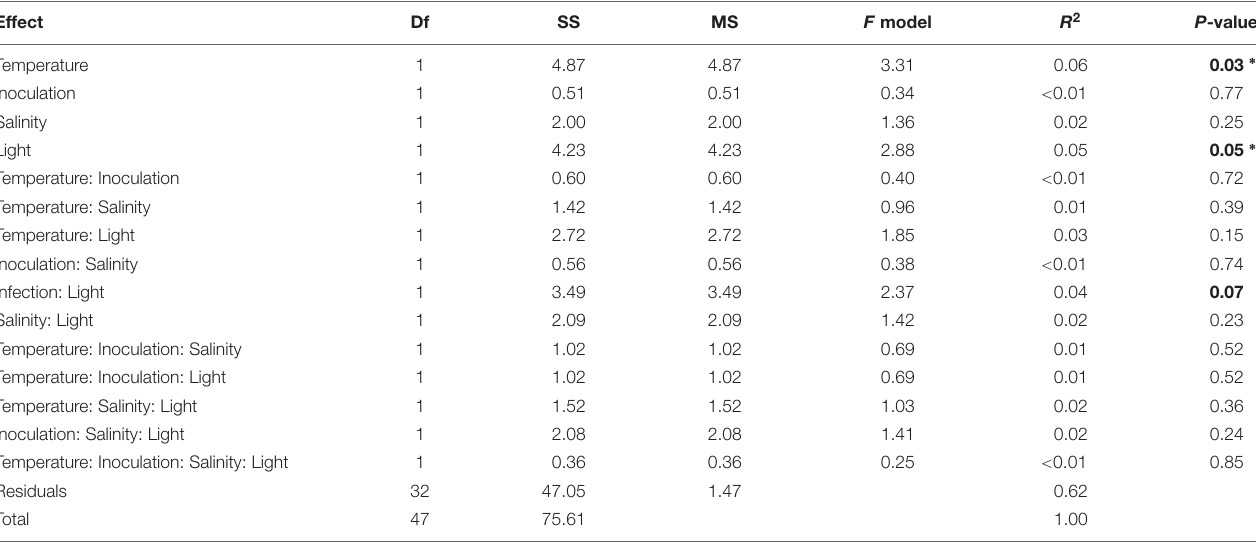
TABLE 3 | PERMANOVA results of eelgrass fitness associated measures (leaf growth rate, side shoot production, survival rate, root starch concentration, leaf starch concentration, leaf sucrose concentration, plant dry weight) according to experimental